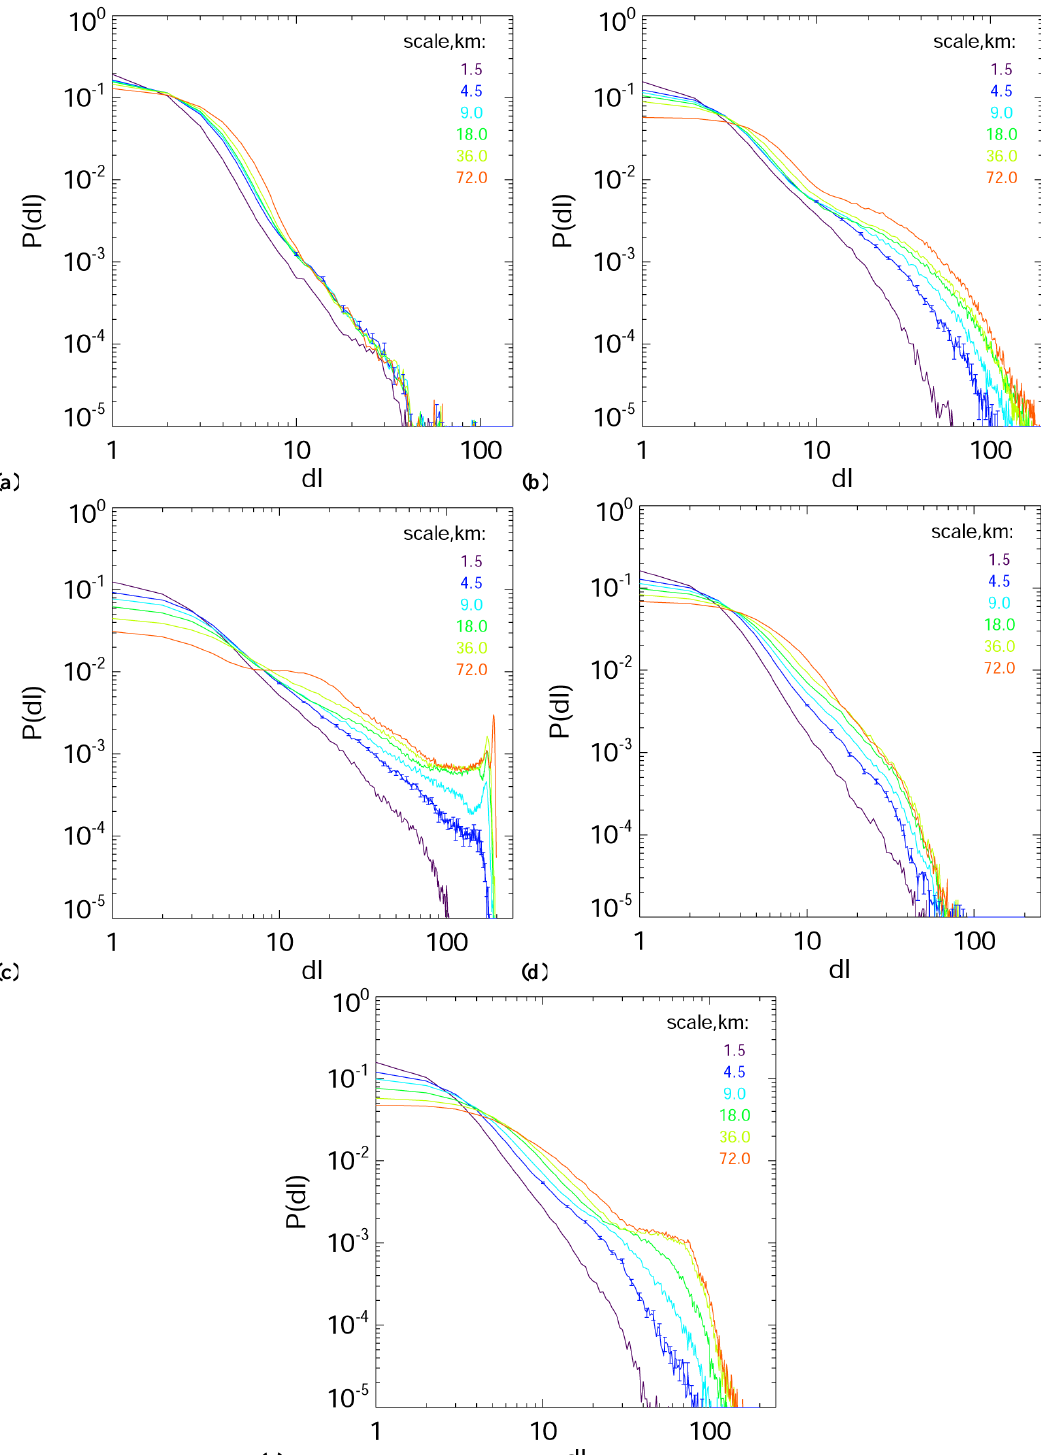
Fig. 4. The same as Fig. 3, but in log-log